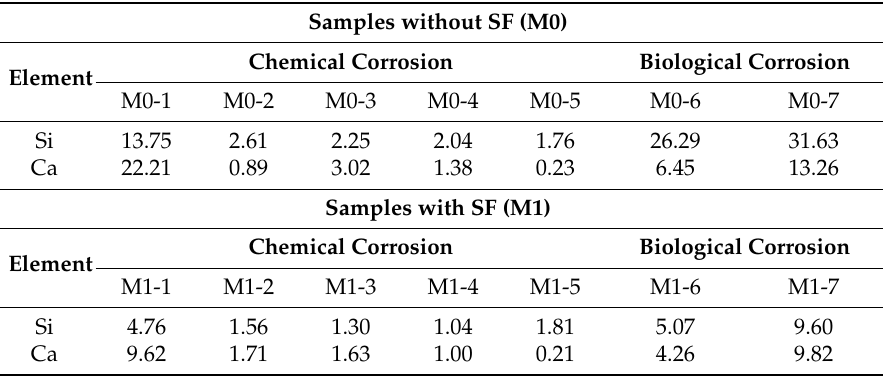
Table 3. The wt % of dissolved Si and Ca.